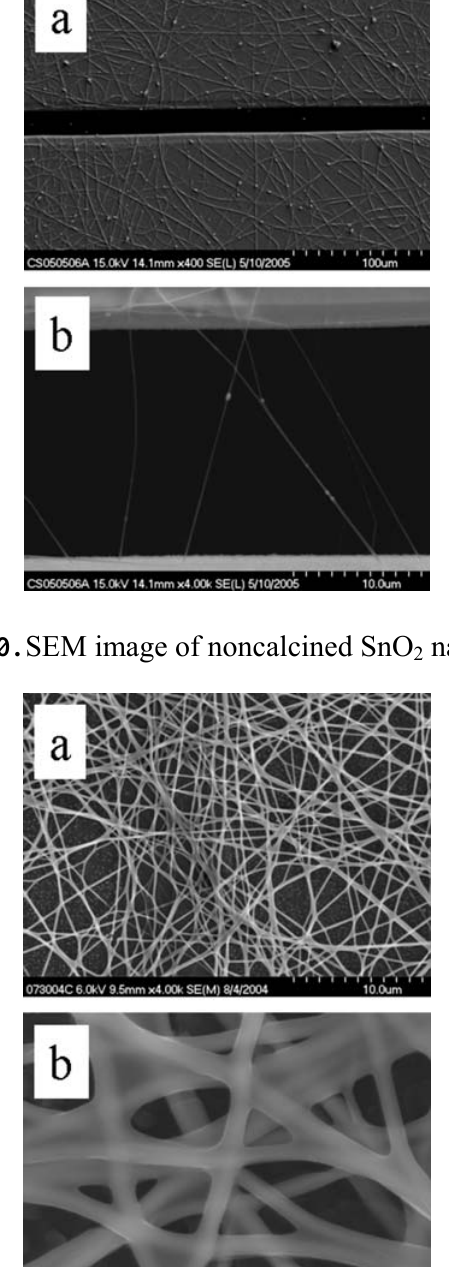
Figure 9. Optical micrograph of electrospun nanofibers bridging across opposing electrodes.